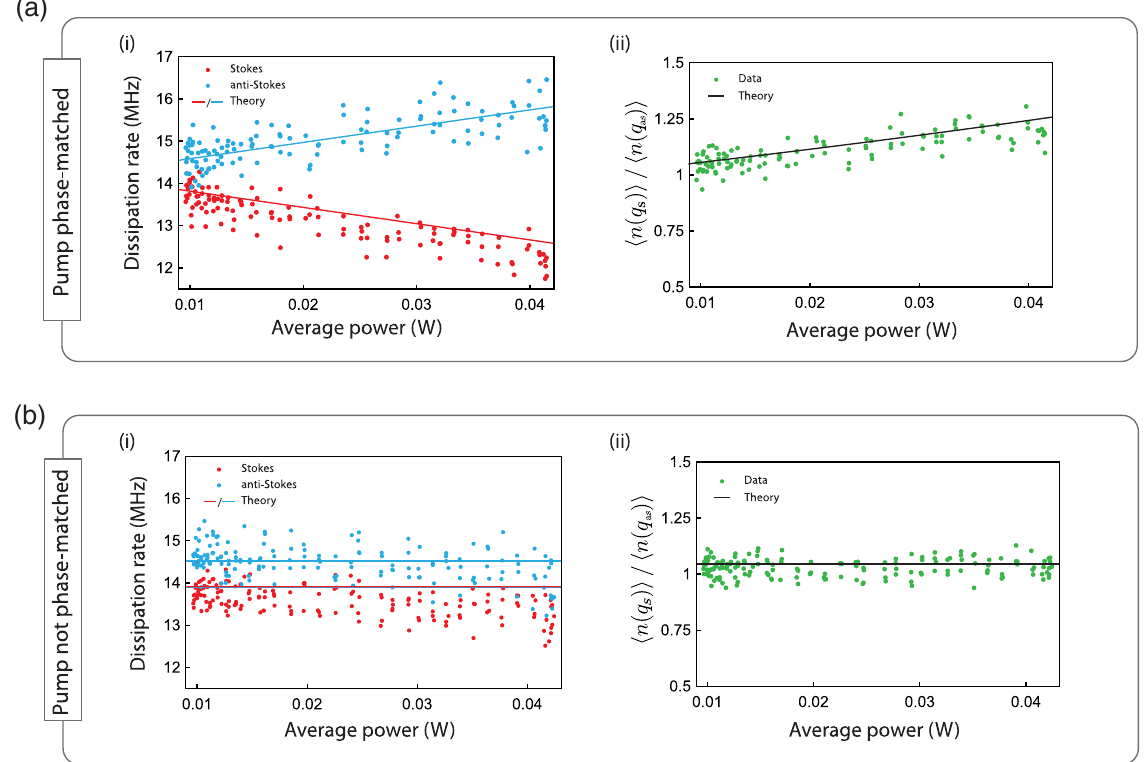
FIG. 5. Pump-probe spontaneous Brillouin scattering measurements. Panel (ai)-(aii) plots the salient effects of a strong pump wave on 2 Þ 1535 . 6 nm, λ ð 1 Þ 1535 . 53 nm). When this phase- the probe spectra when the pump is within the phase-matching bandwidth ( λ ð p ¼ p ¼ matching condition is satisfied (i.e., the pump wave is interacting with the same band of phonon wave vectors), we observe that the anti- Stokes (Stokes) probe spectra experiences linewidth broadening (narrowing) as the pump power is increased (see panel (ai)), revealing that the pump wave coherently modifies the lifetimes of the Stokes and anti-Stokes phonons. Panel (aii) plots the ratio of Stokes to anti- Stokes power (proportional to the ratio of phonon occupations) as a function of total on-chip power and the theoretical trend from the expected change in Stokes and anti-Stokes phonon occupations. Panel (bi)-(bii) plots the spectral widths and relative powers of the Stokes and anti-Stokes light (along with associated theoretical trends) when the pump wave is not phase-matched to the phonons 2 Þ 1537 . 3 nm, λ ð 1 Þ 1535 . 53 nm). We observe that the spectral widths and ratio of Stokes to anti- interacting with the probe wave ( λ ð p ¼ p ¼ Stokes powers remains constant as a function of pump power, which is consistent with the theoretical trend (black). Note that the constant dissipation rate asymmetry is due to the presence of the probe